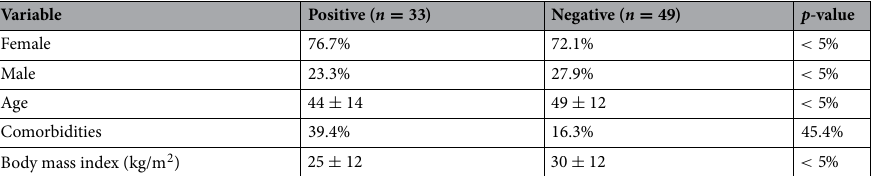
Table 1. Demographic data of volunteers, a set of 82 healthcare workers from “Instituto de Infectologia Emilio Ribas”, São Paulo, Brazil. The list of comorbidities includes rheumatoid arthritis, asthma, diabetes, systemic arterial hypertension, chronic obstructive pulmonary disease, obesity, and